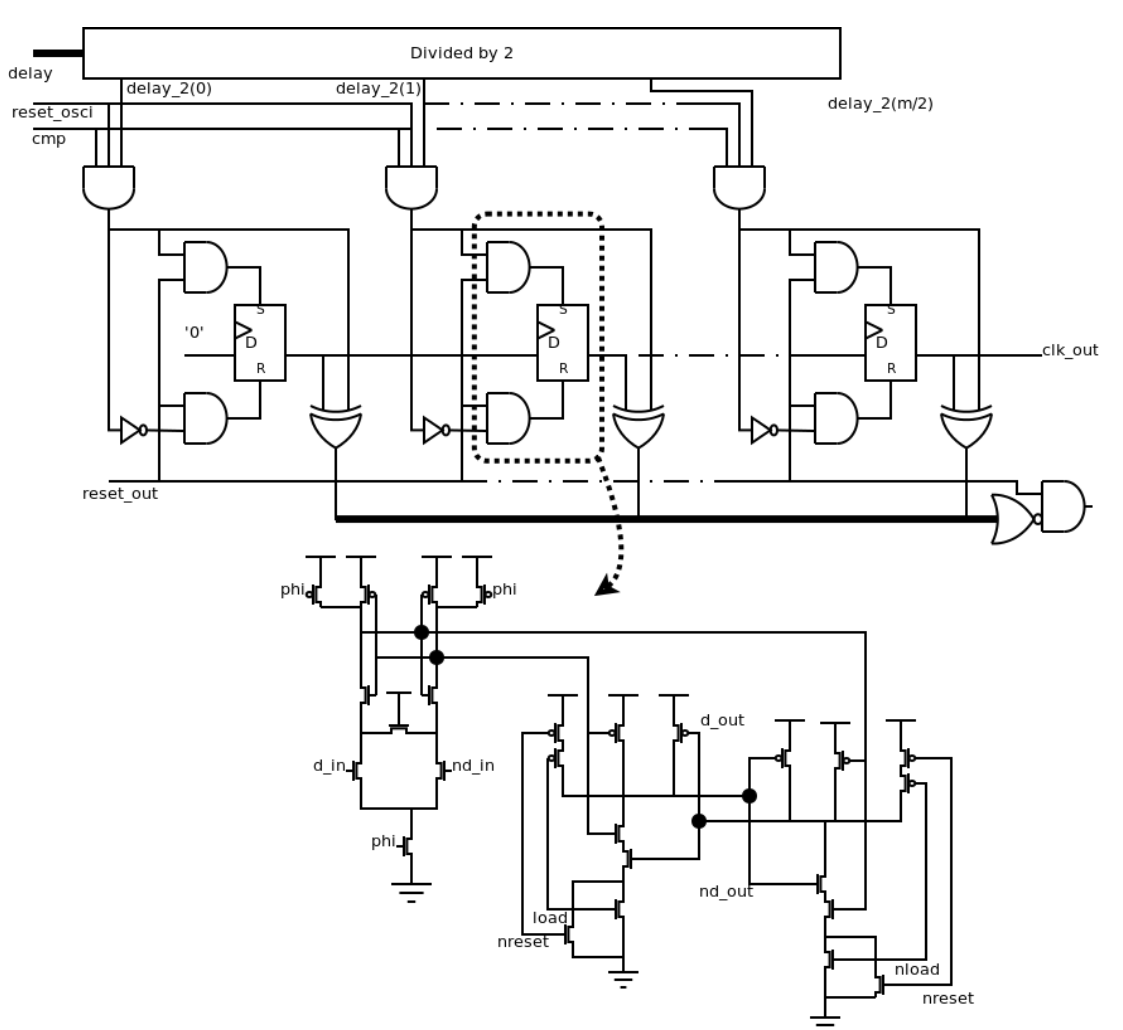
Figure 7. Implementation of the output